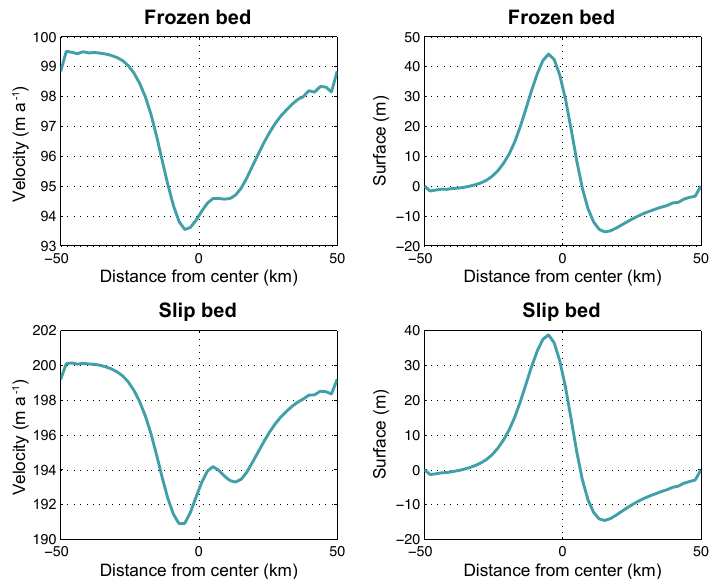
Figure 1. ISSM results for the ISMIP-HOM benchmark Experiment F transient simulation after 1500 years. Surface velocity (ma − 1 ) and steady-state surface elevation profile (m) along the central flowline are shown for the frozen and sliding bed